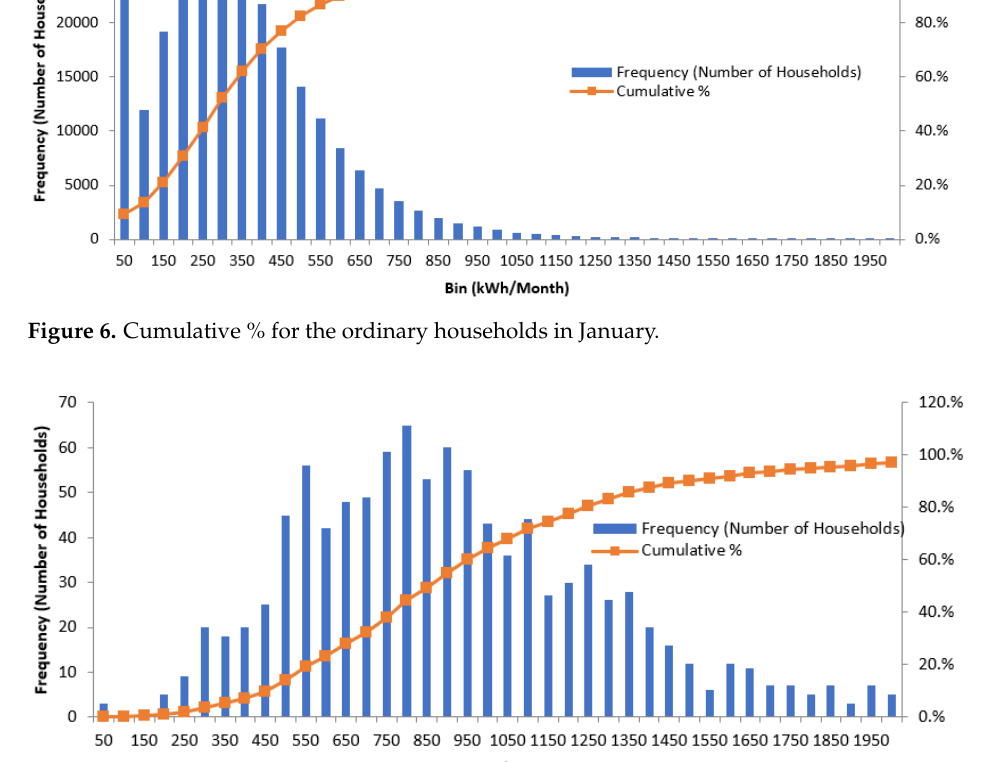
Figure 7. Cumulative % for the subsidised households in January.